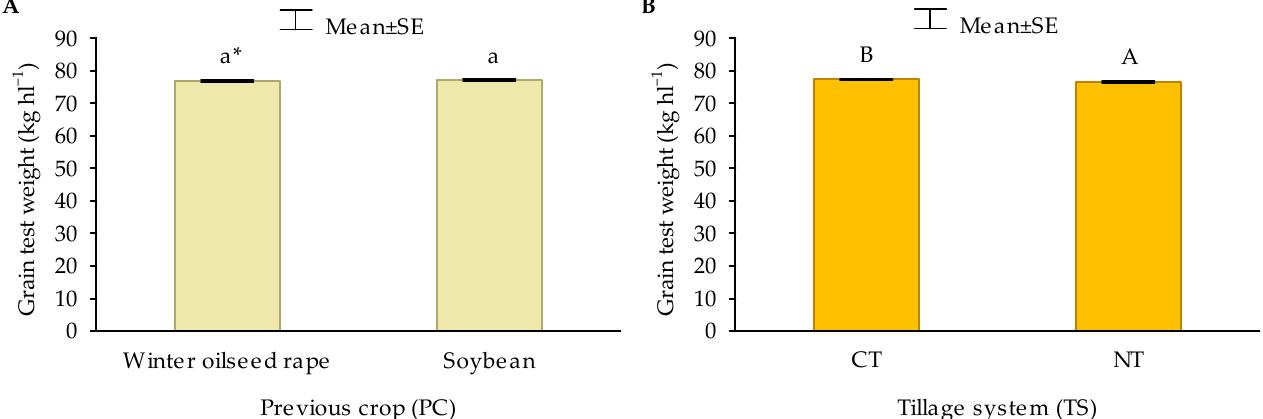
Figure 9. Test weight of winter wheat grain depending on previous crop ( A ) and tillage system ( B ) (mean for 2014–2017).